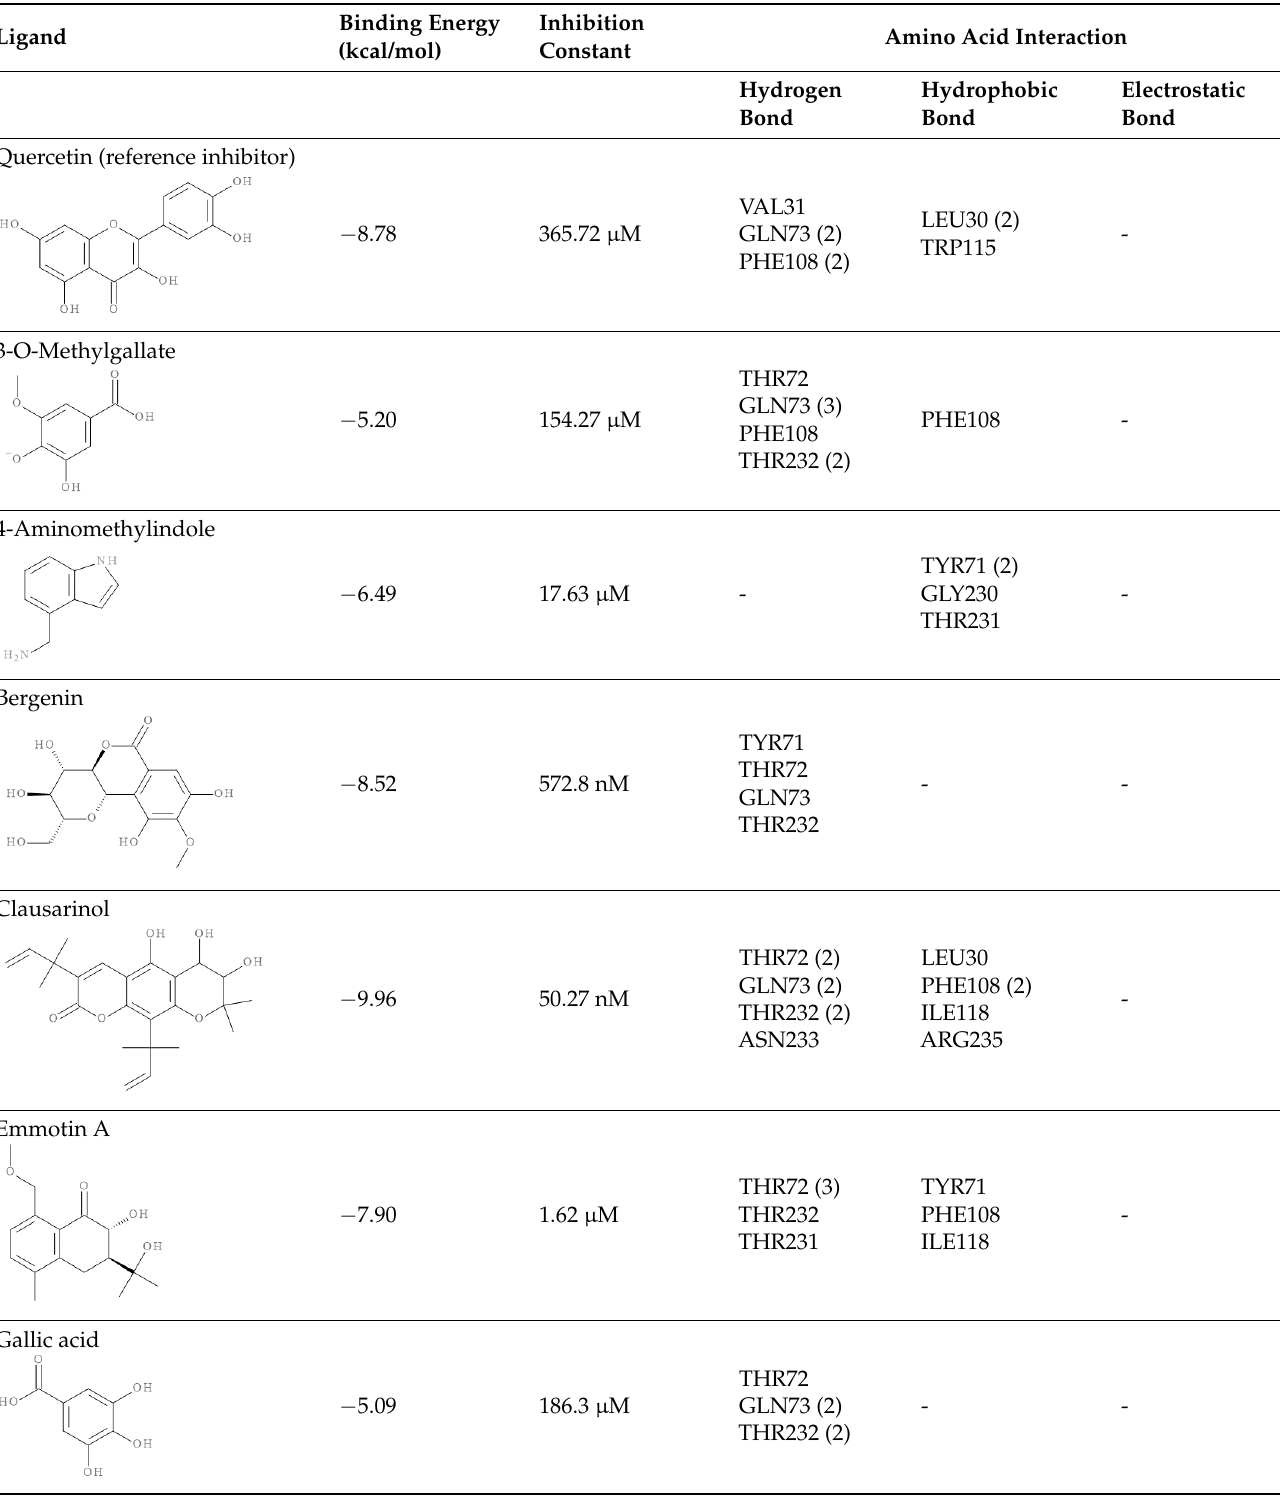
Table 2. The results of molecular docking between the active site of BACE1 (PDB ID: 2WJO) and candidate ligands.